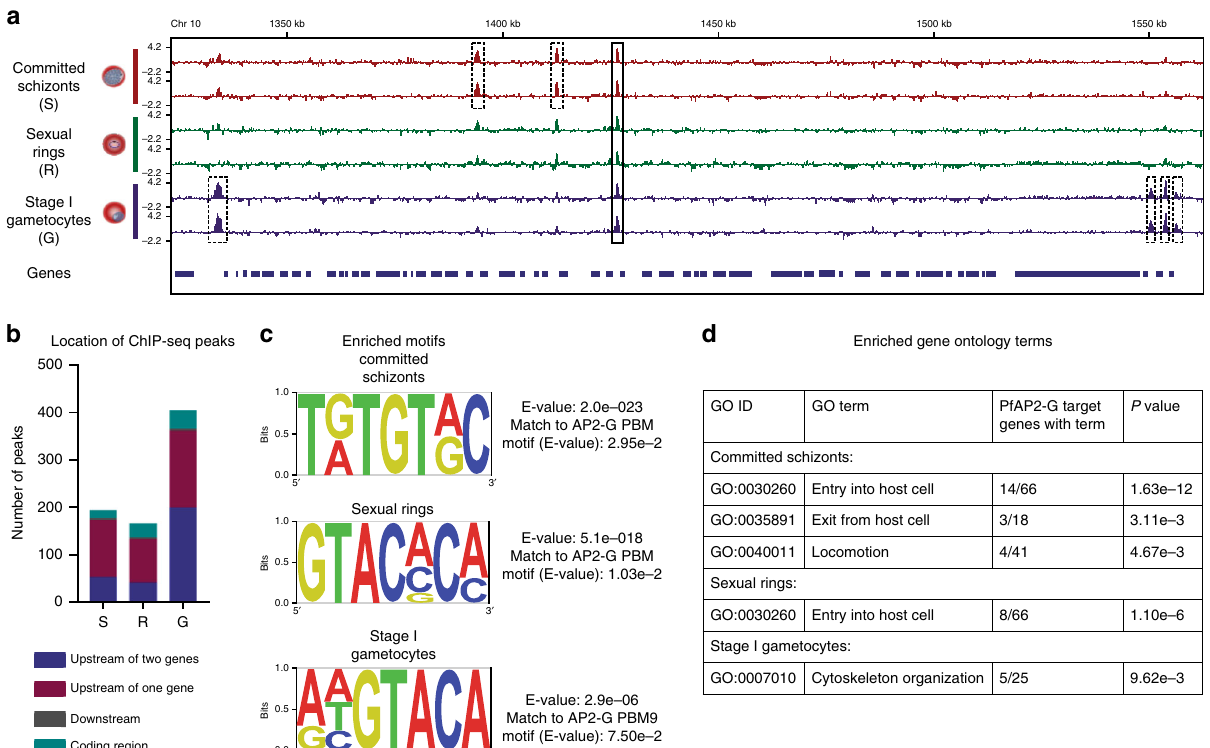
Fig. 1 PfAP2-G dynamically binds hundreds of sites across the genome throughout commitment and early gametocytogenesis. a Log2-transformed PfAP2-G ChIP/input ratio tracks for committed schizonts (red), sexual rings (green), and stage I gametocytes (purple) over a region of chromosome 10. Dashed boxes highlight stage-speci fi c binding sites and solid boxes indicate common binding sites. The blue bars underneath show the locations of genes. Data are shown for each of two biological replicates per stage. b Bar plot showing the number of PfAP2-G binding sites identi fi ed in each stage using ChIP- seq, with the location of each peak indicated by colour. c DNA motif analysis of ChIP-seq peaks using DREME identi fi ed GTRC (committed schizonts) and GTAC (sexual rings and stage I gametocytes) as the top-scoring motifs. Comparison of each motif to known DNA motifs bound by recombinant AP2 domains using Tomtom showed that all three motifs match most closely to the DNA motif bound by the AP2 domain of PfAP2-G. d Gene ontology analysis of the closest genes within 2kb of a PfAP2-G binding site for each